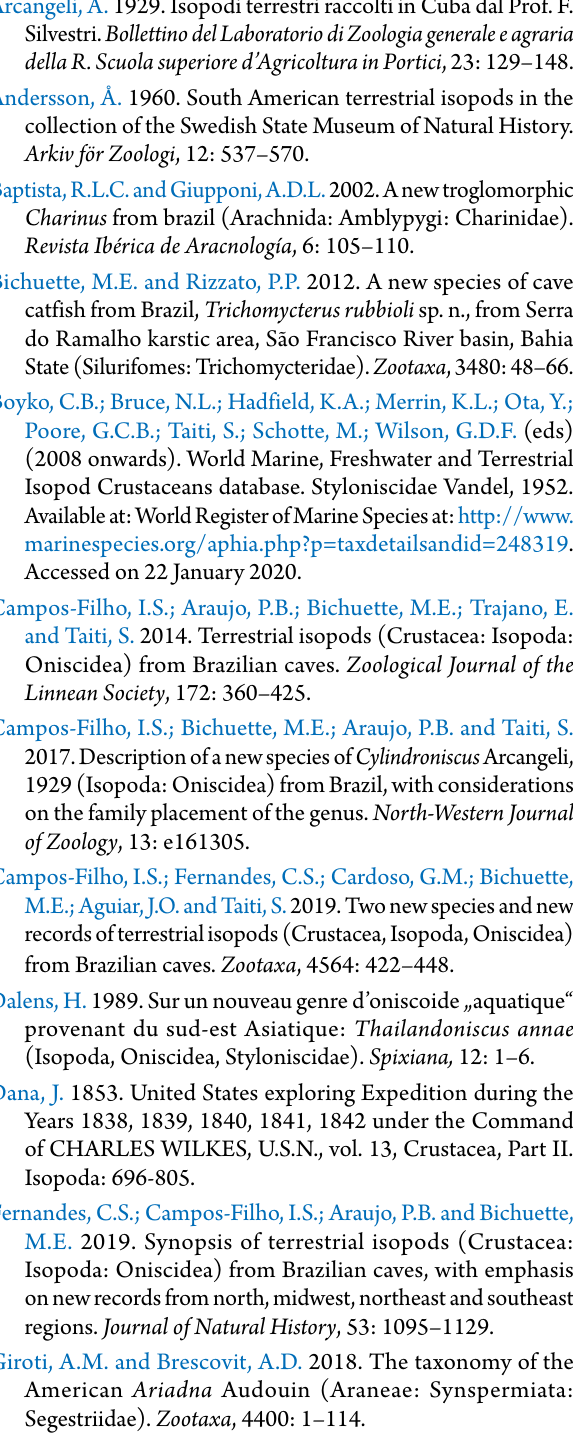
figure 20. License number: 55272-1 and 54444-6. r